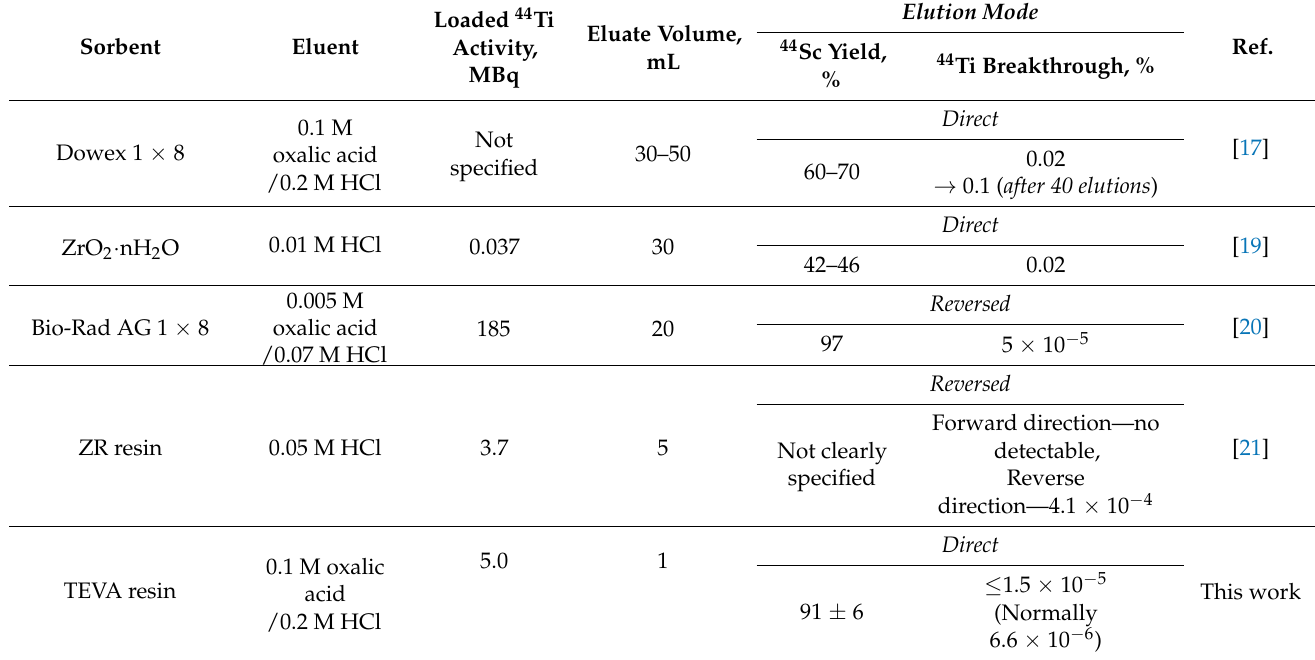
Table 8. Characteristics of various chromatographic 44 Ti/ 44 Sc generators reported so